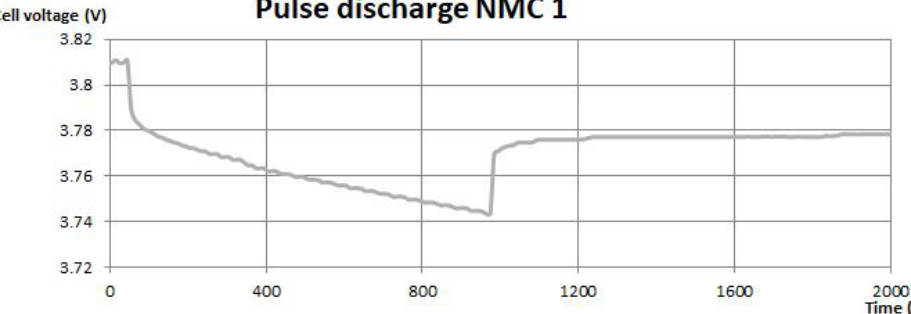
Figure 3. Dependency between the voltage of the NMC1 cell and time during pulse discharge tests.